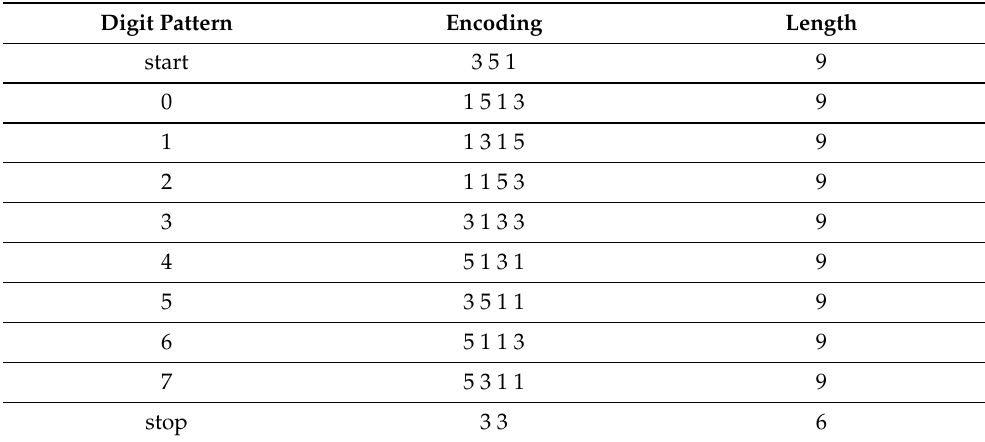
Table 1. Barcode’s encoding rule of digit pattern.